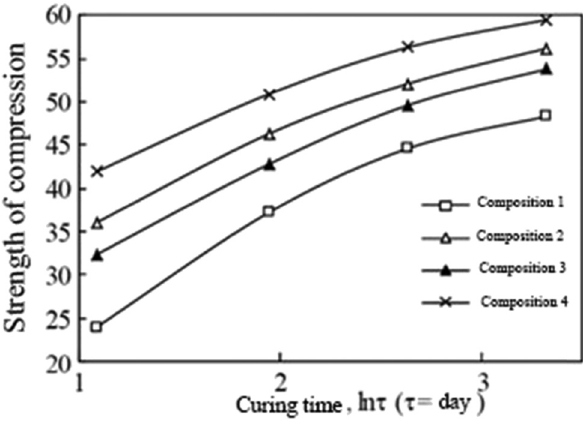
Figure 12: Kinetics of strength growth of cement